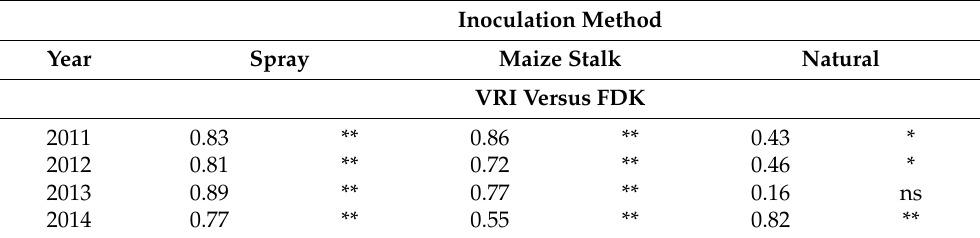
Table 4. Spearman’s rank correlation coefficients between visual rating index (VRI) and Fusarium- damaged kernels (FDK) under spray inoculation, maize stalk inoculation, and natural infection in 2011, 2012, 2013, and